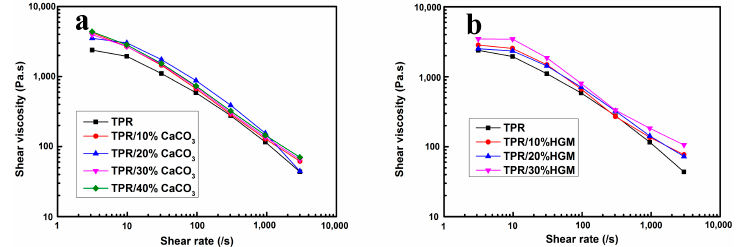
Figure 1. Shear viscosity versus shear rate of various ( a ) TPR/CaCO 3 composites and ( b ) TPR/HGM composites. PR: Melt blending of PP with EPDM (PP/EPDM = 30/70); HGM: hollow glass